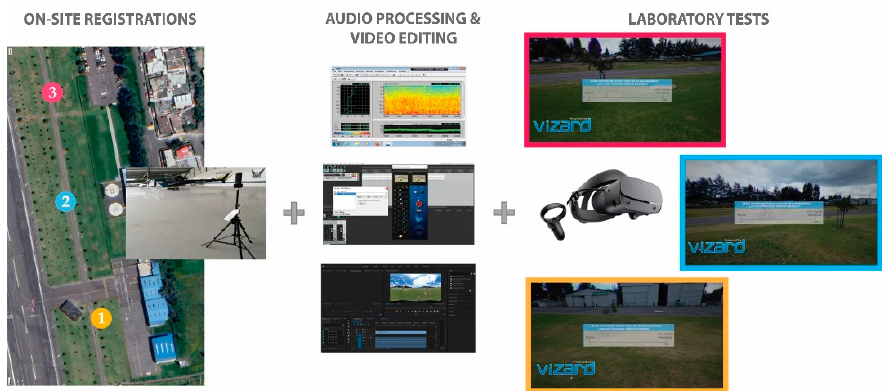
Figure 2. Workflow for the development of the laboratory tests.